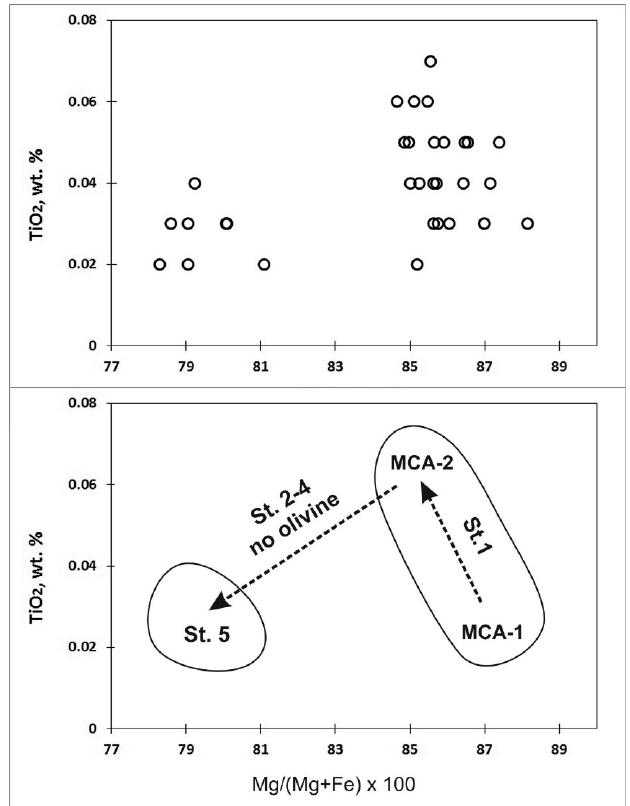
Figure 9. Crystallization of olivine from megacrystic melt in Monastery kimberlite (S. Africa), after the model of Moore [59]. Circles are olivine megacrysts from Monastery kimberlite (data from work in [37]). Crystallization steps: 1 = oliv + opx + cpx + gnt, 2 = cpx + gnt + opx + ilm, 3 = phlog + ilm, 4 = zircon + phlog + ilm, 5 = zircon + Fe-oliv + phlog + ilm.